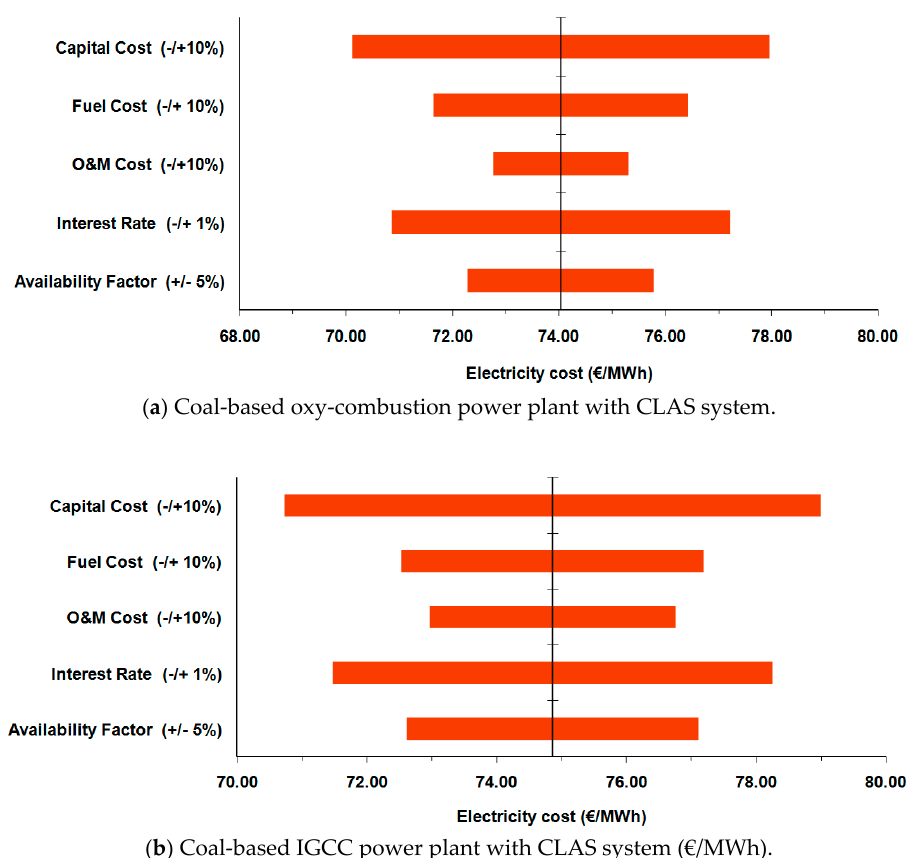
Figure 6. Electricity cost sensitivity analysis for coal-based oxy-combustion and IGCC power plants equipped with CLAS system.